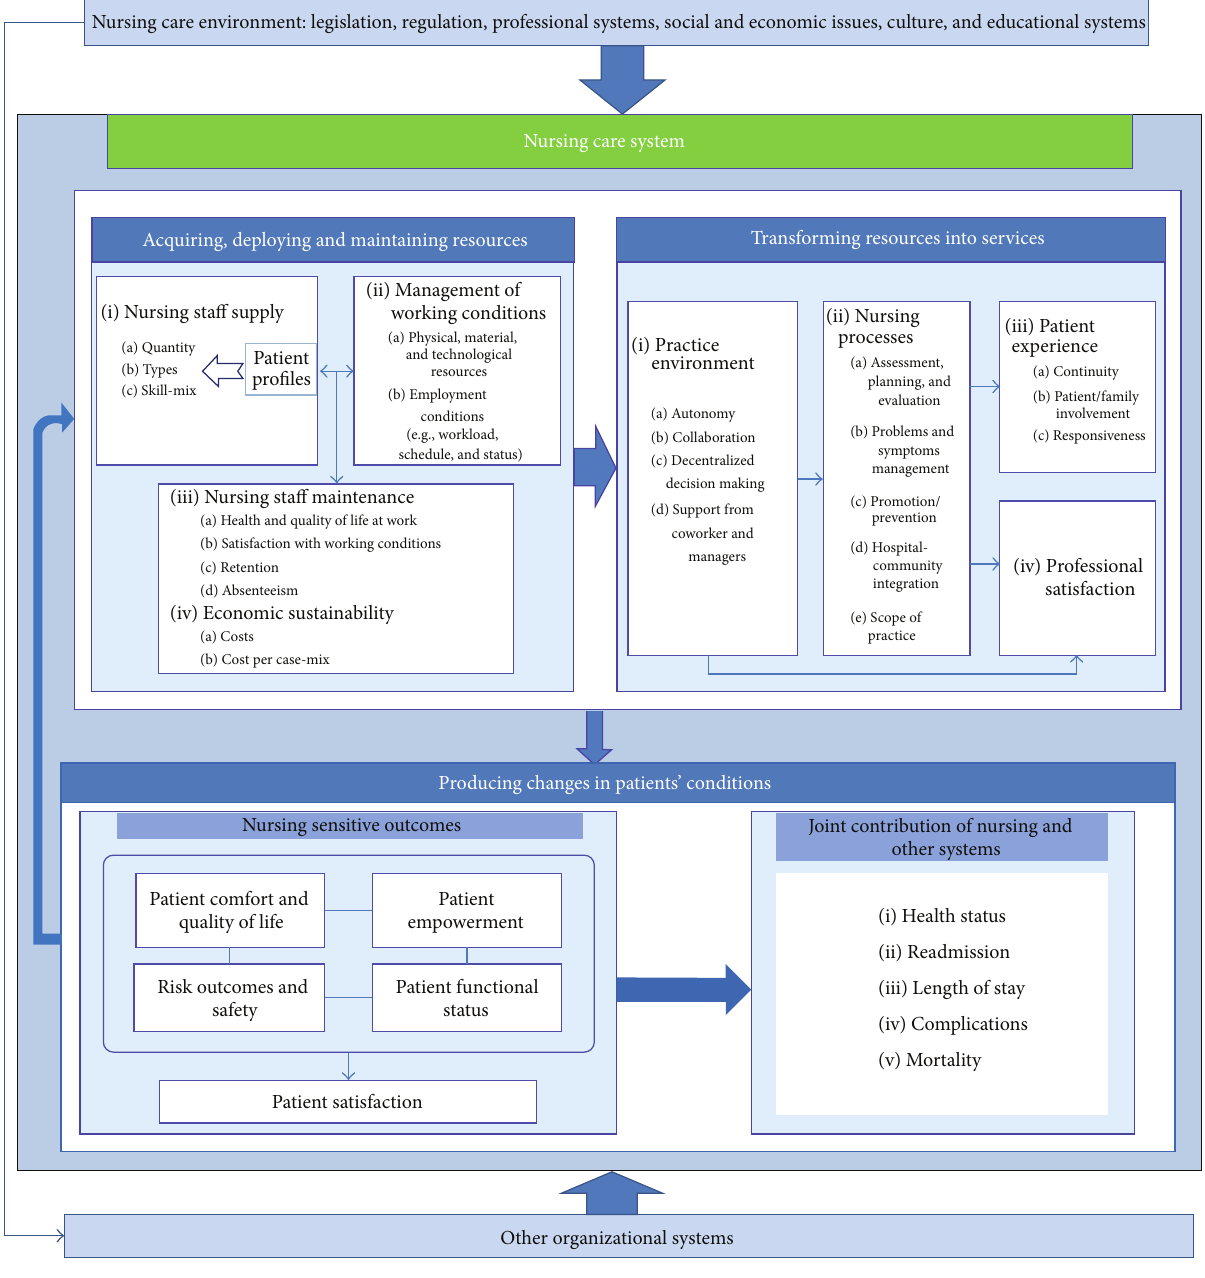
Figure 1: Nursing Care Performance Framework (NCPF) developed by Dubois et al.